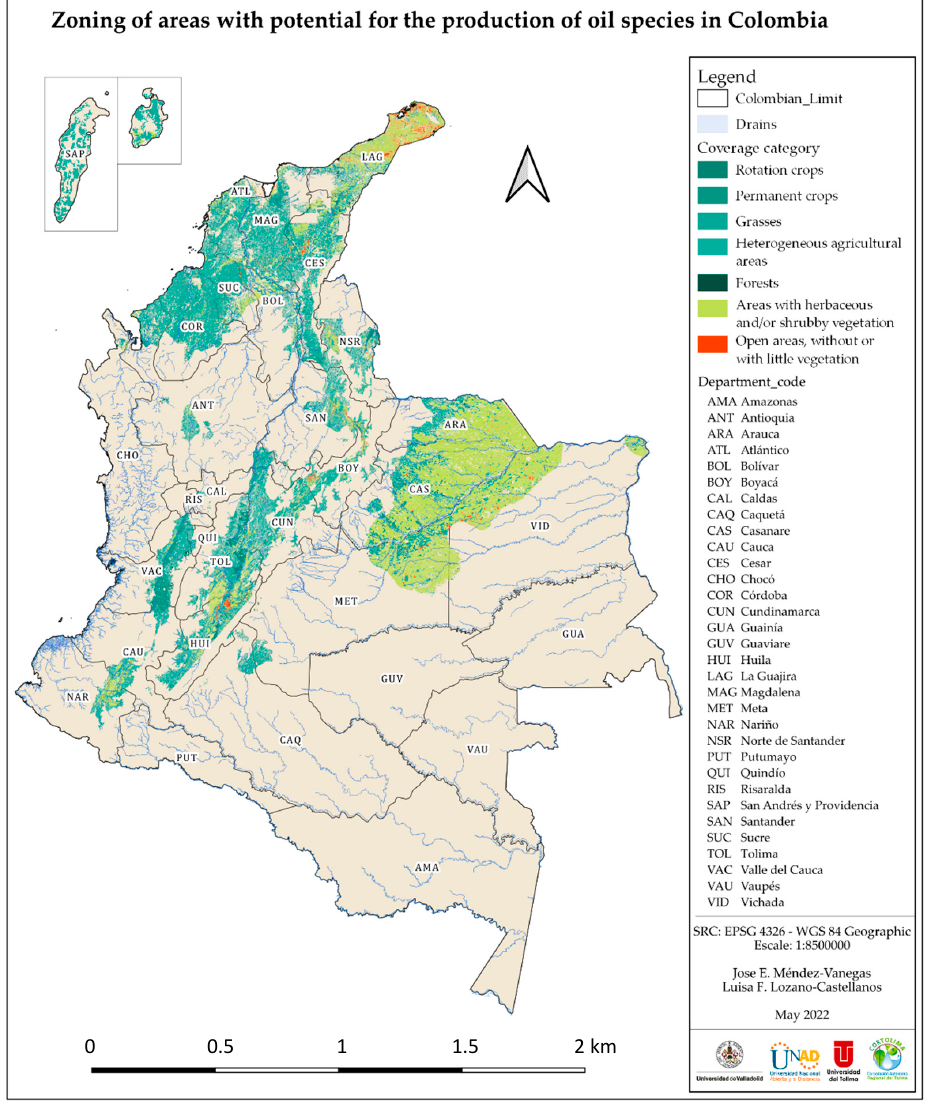
Figure 5. Zoning of areas with the potential to produce oil species in Colombia. Table 4. Oilseed species association and its relation with the coverages: rotation crops (RC), permanent crops (PC), grasses (G), heterogeneous agricultural areas (HAA), forest (F), areas with herbaceous and/or shrubby vegetation (HSV), and open areas (OA) in the ten principal departments for production.